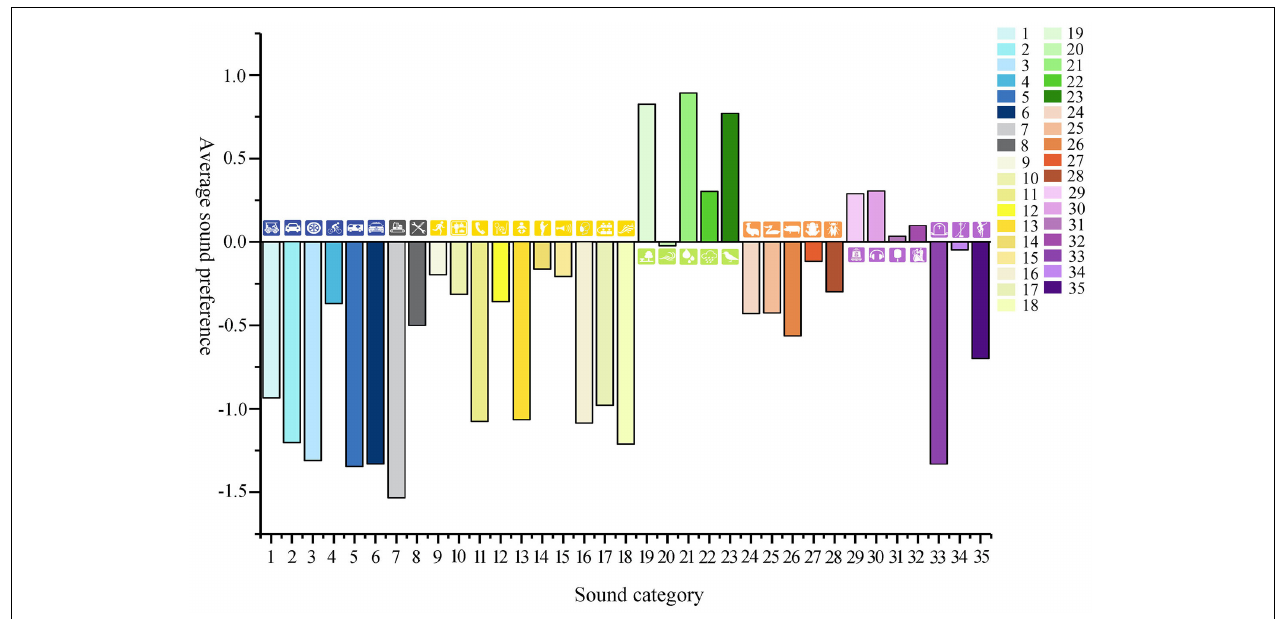
FIGURE 4 | Columnar distribution of the mean value of soundscape preference (code is shown in Table 1